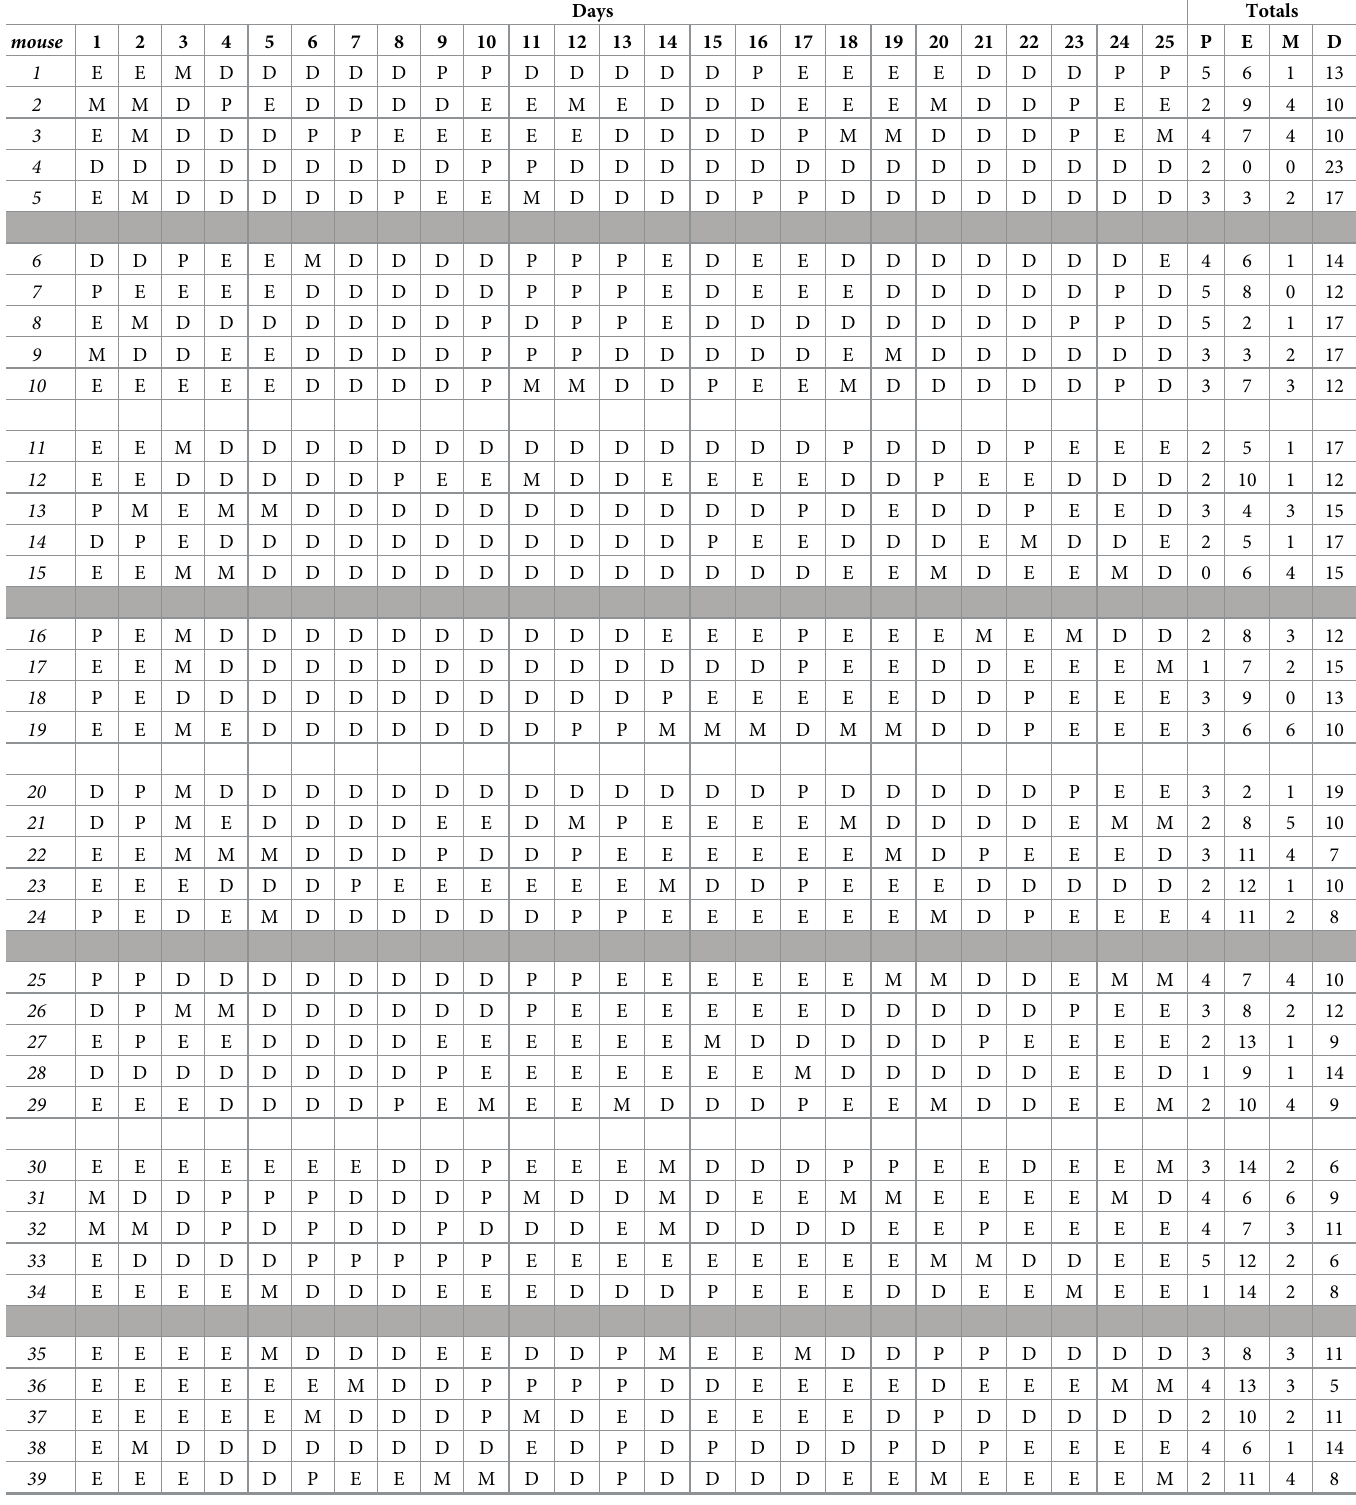
Table 1. Estrous cycling in example animals. Proestrus ( P ), estrus ( E ), metestrus ( M ), and diestrus ( D ).